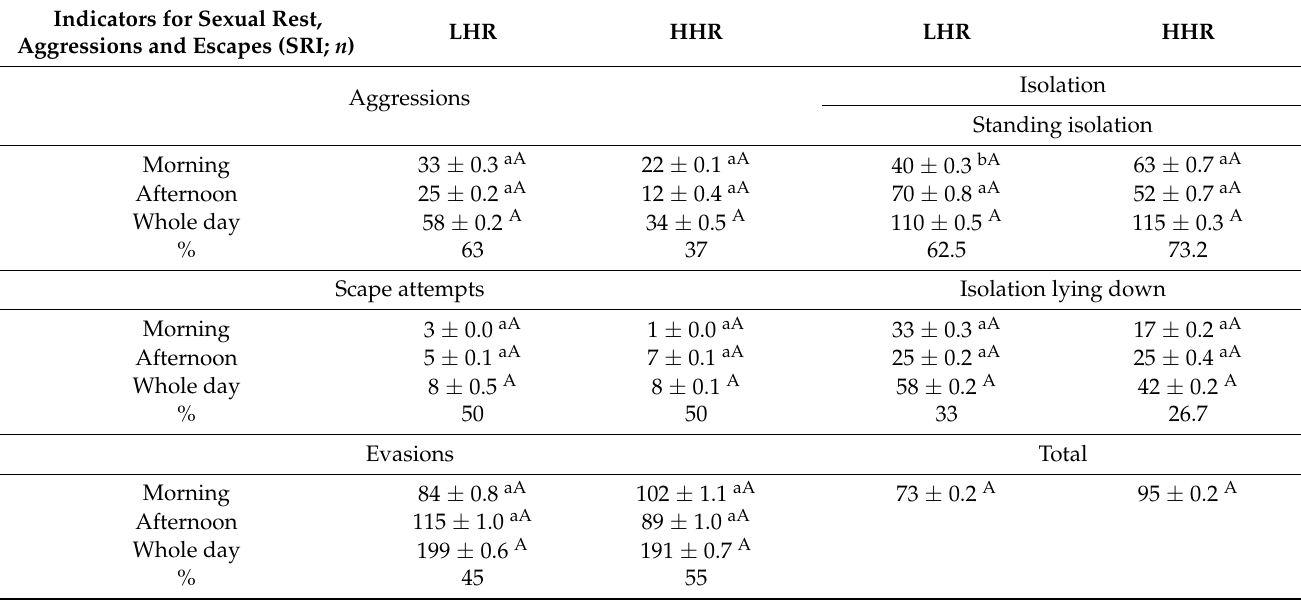
Table 6. Sexual inactivity, aggressions, and escapes (SRI; n = 8) of low (LHR) or high social ranking (HHR) Dorper rams during the morning and afternoon under natural photoperiod, when joined to anovulatory ewes.